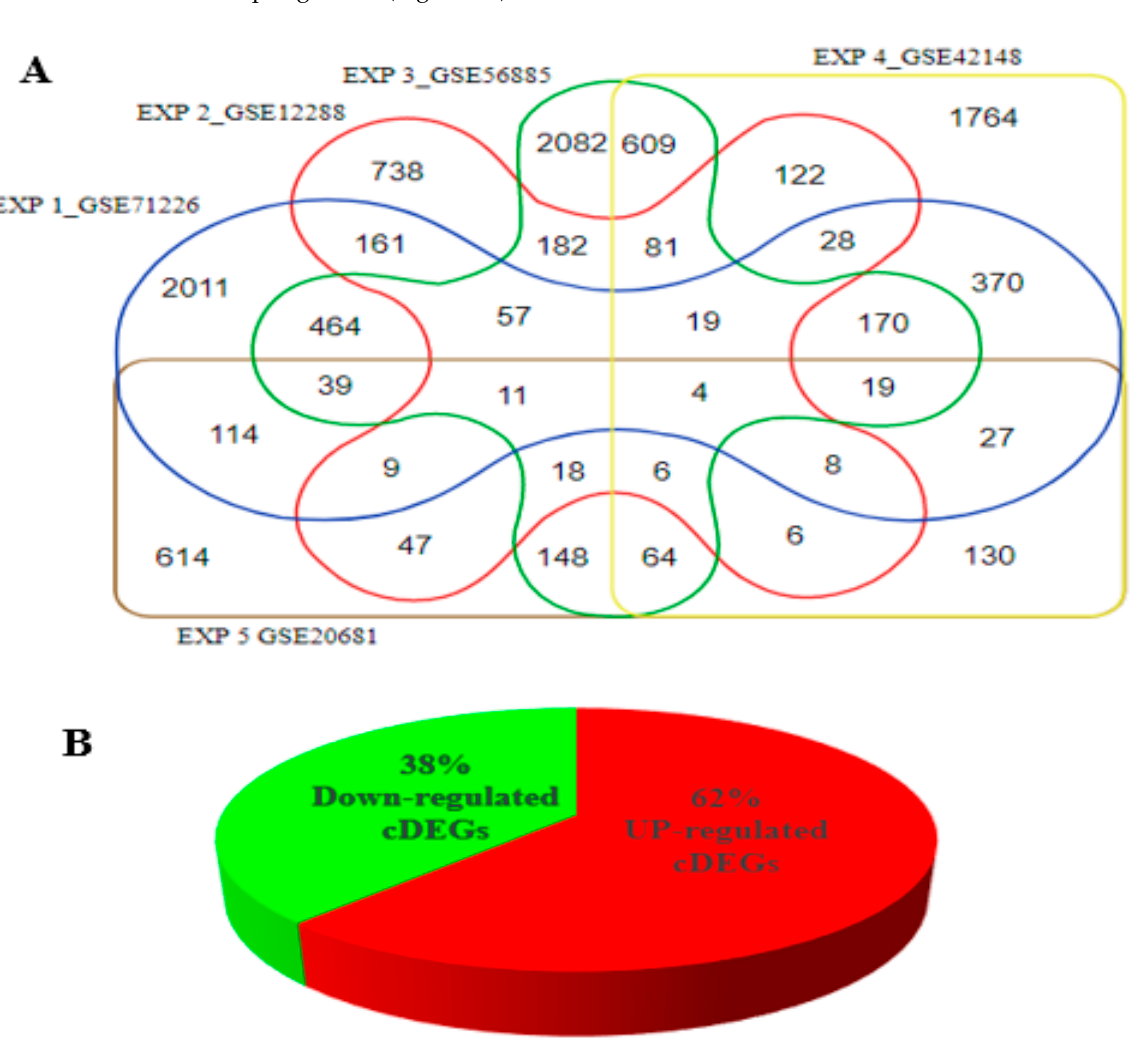
Figure 3. Number of differentially expressed genes (DEGs) implicated in CHD. ( A ): number of genes distributed among the five experiments used in the study. ( B ): percentage composition of up-regulated and down-regulated genes associated with CHD implicated in at least three of the five experiments selected